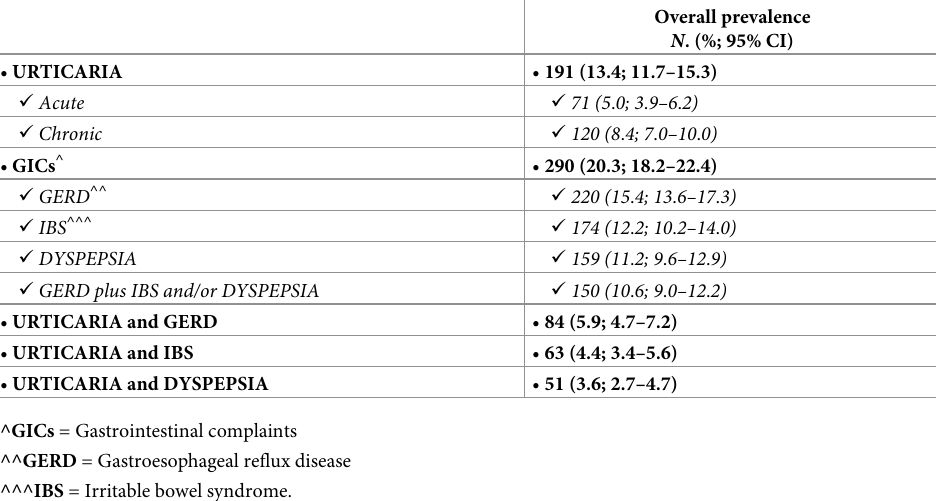
Table 1. Prevalence of urticaria and main gastrointestinal complaints in all 1426 consecutive patients.